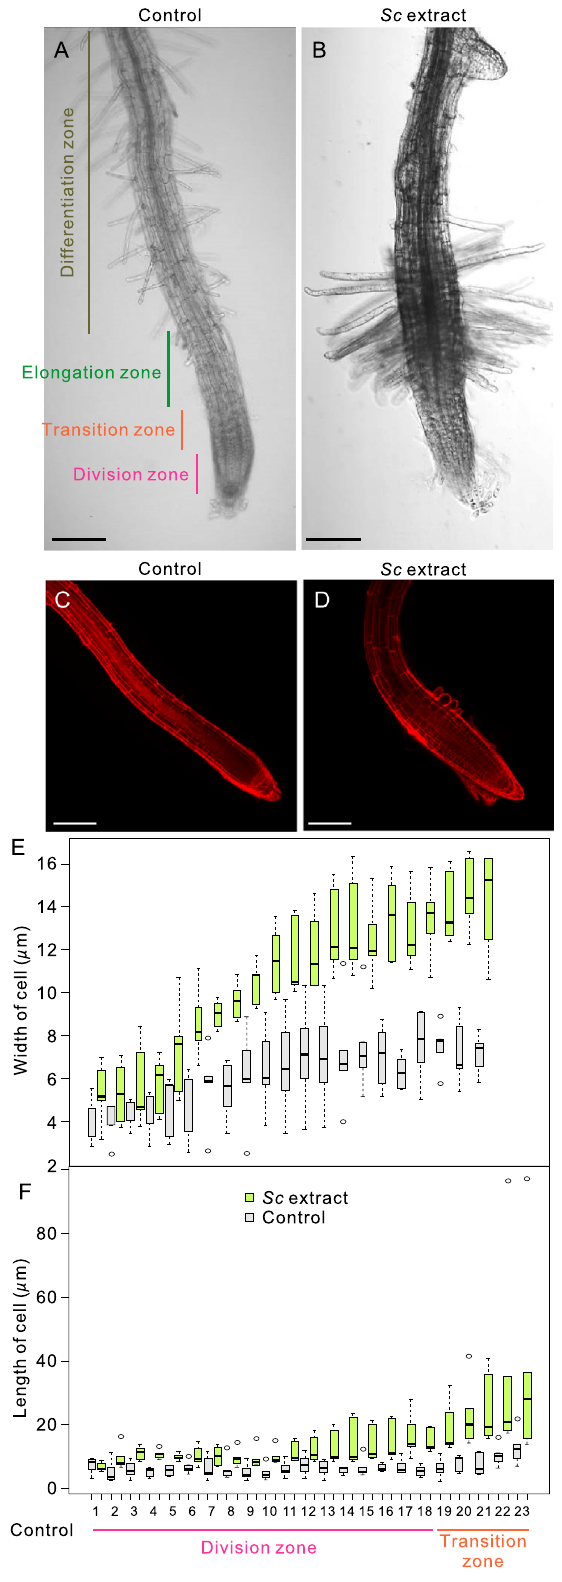
Figure 2. Morphological changes in the root-tip region of Arabidopsis after S. chinensis extract treatment. The morphology of the root-tip region of Arabidopsis seedlings without ( A ) or with ( B ) S. chinensis extract treatment . Propidium iodide-stained root tips of Arabidopsis seedlings without ( C ) or with ( D ) S. chinensis extract treatment . The length ( E ) and width ( F ) of the root epidermal cells were measured from the initial root epidermal cell. Numbers represent the cell number from the initial cell. Blue: control, orange: after S. chinensis extract treatment . Asterisks denote significant differences based on the Mann– Whitney U -test ( p < 0.05); n = 3 biological replicates of five seedlings each. Scale bars: 100 µm ( A – D